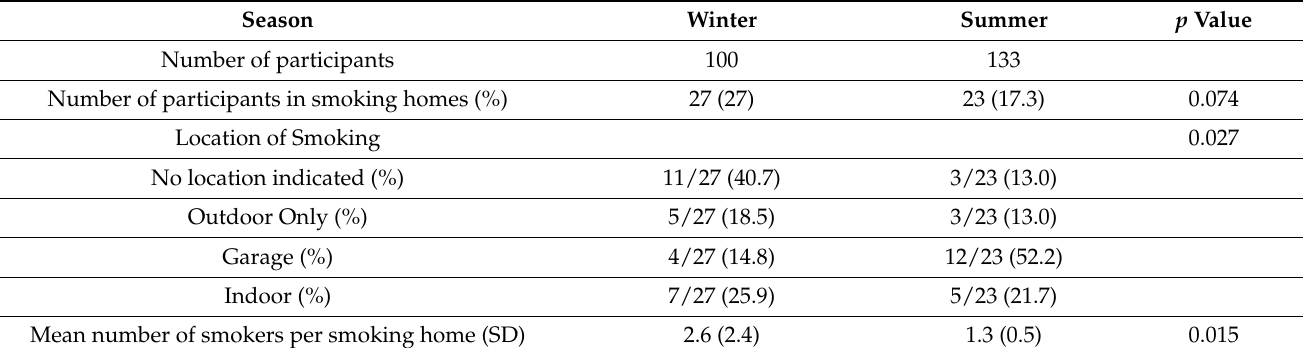
Table 1. Seasonality of smoking for all participants who completed